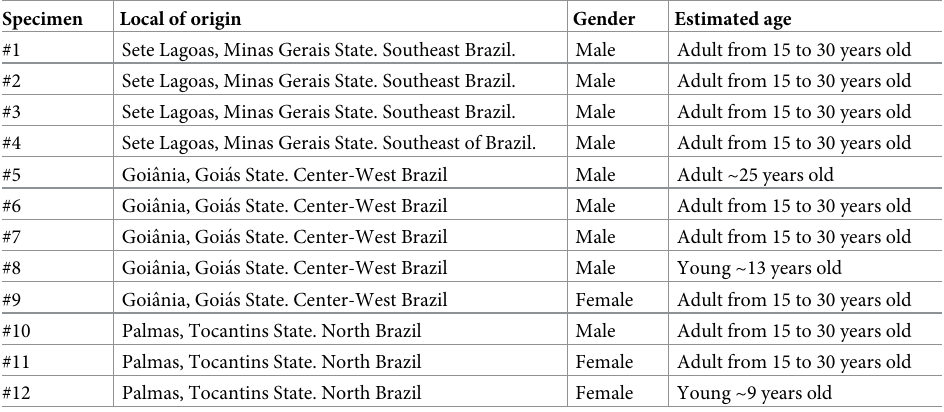
Table 1. Specimens used this work, their location of origin, gender and estimated age.